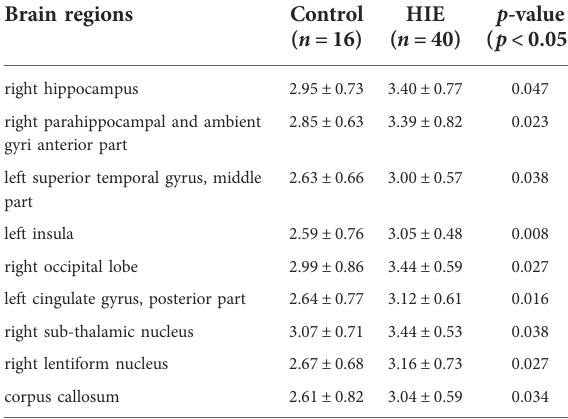
TABLE 2 Brain regions with signi fi cant APT signal intensity differences between the control and HIE groups.